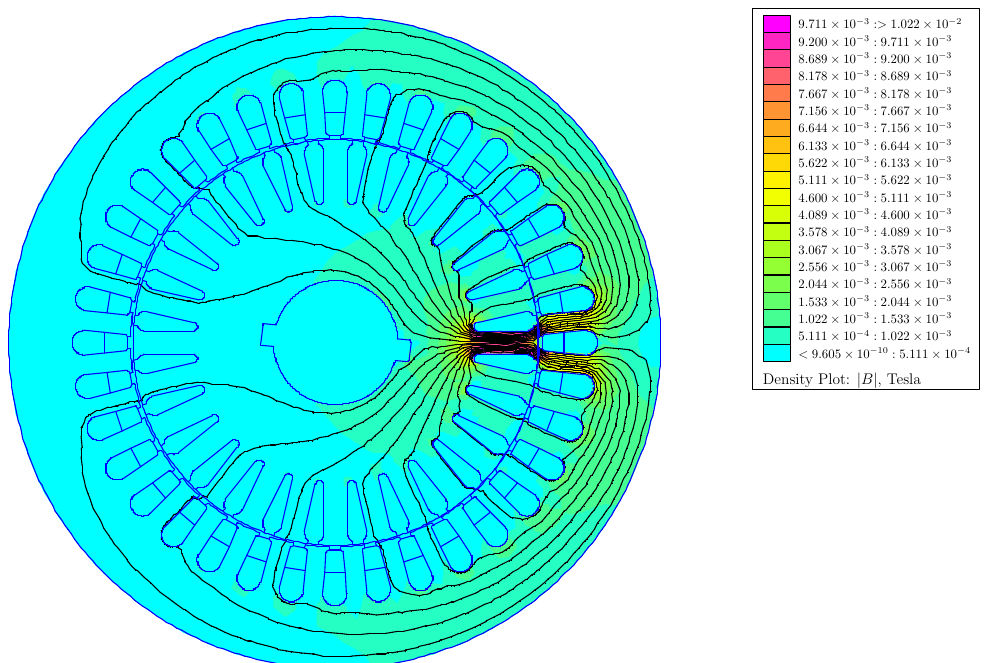
Figure 16. FEM simulation of the IM of Appendix A for a mixed eccentricity with a static eccentricity degree of 40% ( δ s = 0.4) and a dynamic eccentricity degree of 20% ( δ d = 0.2), with only the first rotor phase fed with a 1 A constant